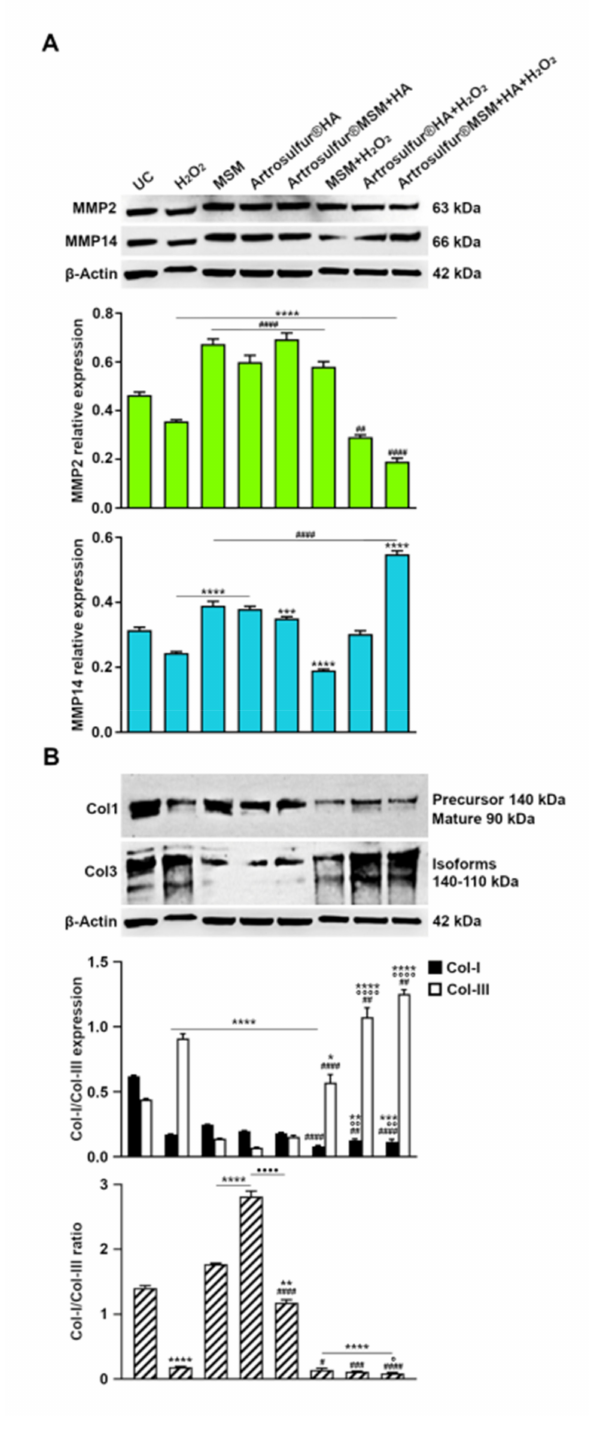
Figure 4. ( A ) Western blot analysis of metalloproteinases 2 (MMP2) and 14 (MMP14) protein expression in RCT-derived tenocytes in the indicated experimental conditions and ( B ) Western blot analysis of collagen type 1 and collagen type III protein expression in RCT-derived tenocytes in the indicated experimental conditions: β -actin is used as control. Bar graphs display densitometric values expressed as the mean percentage ± SD ( n = 3) of normalized on β -actin. * p ≤ 0.05, ** p ≤ 0.01, *** p ≤ 0.001, and **** p ≤ 0.0001, between median values of treated samples and untreated cells; # p ≤ 0.05, ## p ≤ 0.01, ### p ≤ 0.001, and #### p ≤ 0.0001, between median values of HA-treated samples + H ◦ ◦◦ ◦◦◦◦ p ≤ 0.05, p ≤ 0.01, and p ≤ 0.001, between median values of HA-treated samples + H 2 O 2 and MSM + H 2 O 2